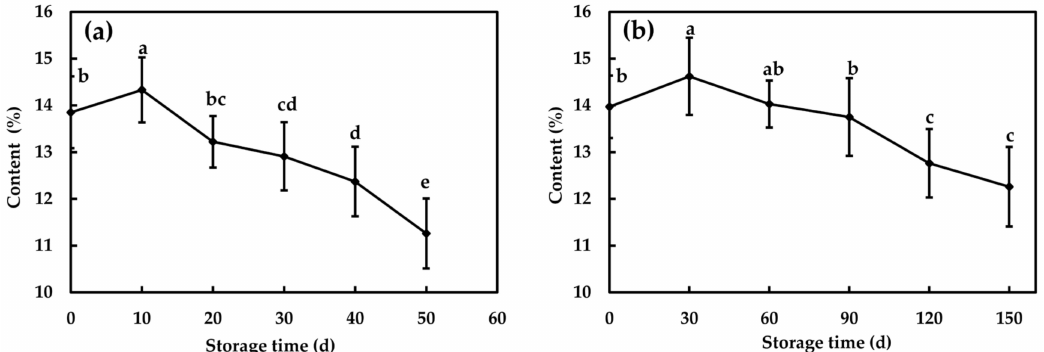
Figure 4. Soluble solid content (SSC) of Fuji apple flesh for six storage times at 25 ◦ C ( a ) and 0 ◦ C ( b ). Data at six storage time with di ff erent letters are significantly di ff erent with p < 0.05. The vertical bars denote standard deviations. d, day.